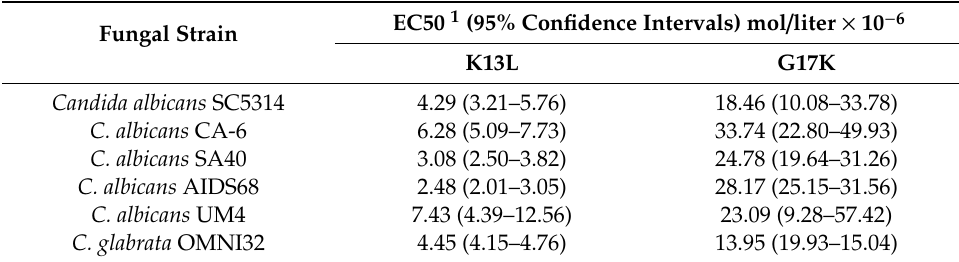
Table 2. In vitro fungicidal activity of K13L and G17K against candidal strains.